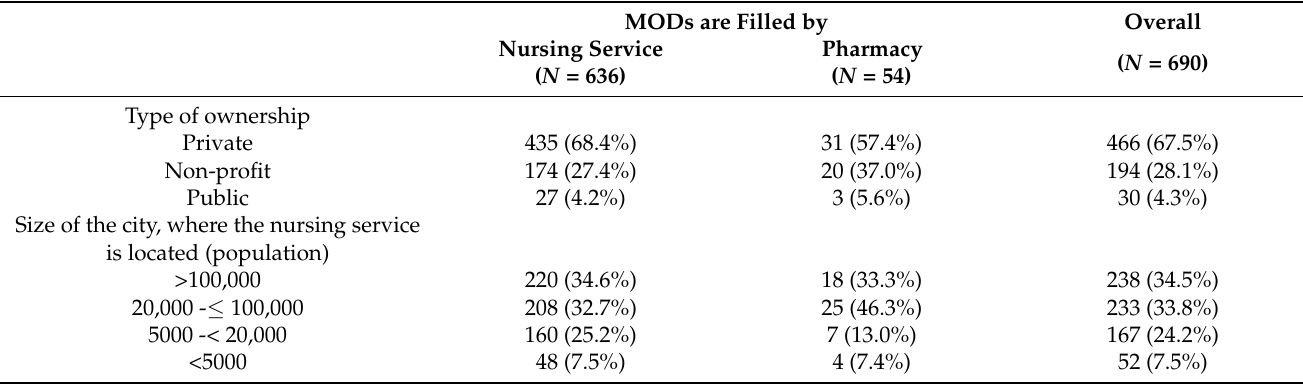
Table 1. Characteristics of home care nursing services providing long-term medication for care recipients with an MOD prescription, by filling